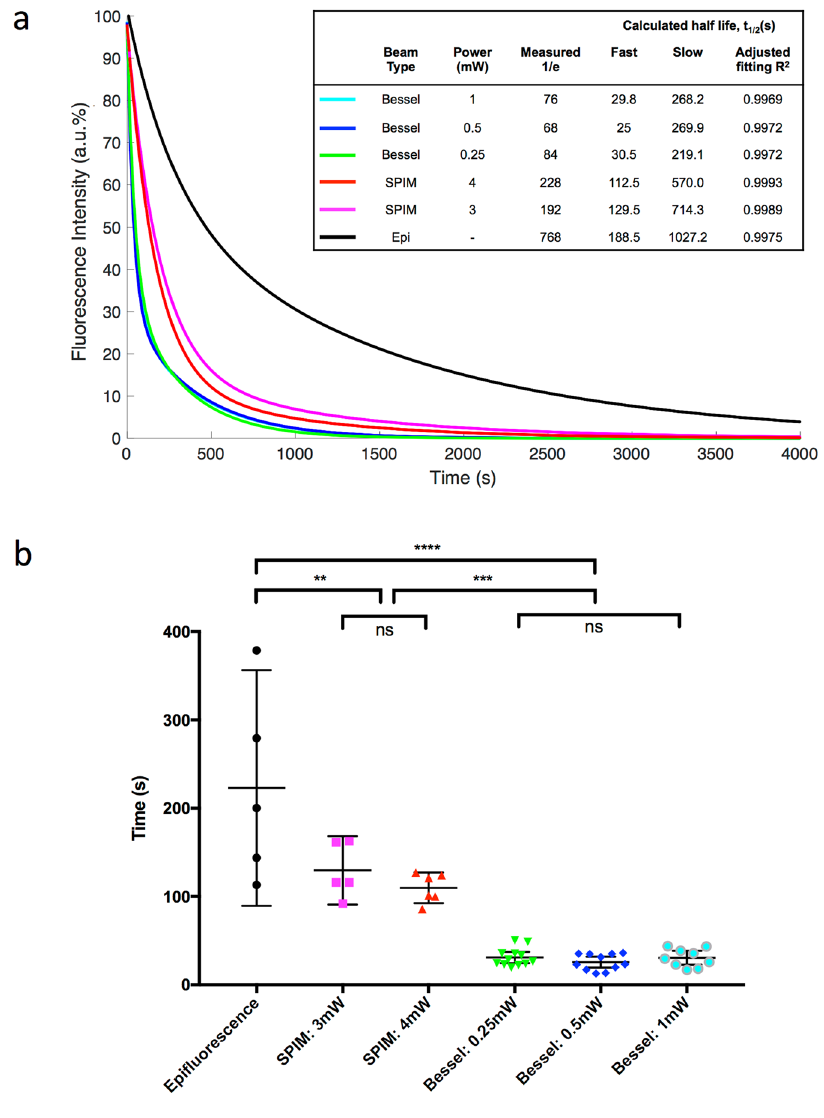
Figure 3. Fitting of decay curves highlights distinction between targeting speed. ( a ) Averaged fluorescence intensity profiles for each group were fitted to two-term exponential functions. The calculated fast and slow decay curve half-lives were calculated and are show, along with the measured time for the curve to reach 1/e. The curve fitting precision is represented by the adjusted R2 value. ( b ) Individual fluorescence intensity decay curves were fitted to two-term exponential functions for each sample. KillerRed photobleaching follows this two-term decay curve extremely well, comprising a fast and a slow decay component. The half-life was calculated from the fast term of each fitted curve, and averaged for each group. Individual points are plotted, with error bar designating the 95% confidence intervals. ** p < 0.01, **** p <